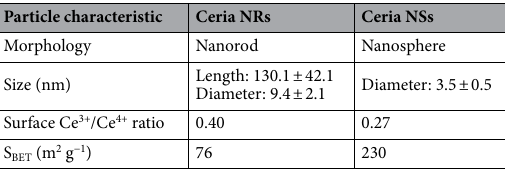
Table 1. Characterization of ceria nanoparticles. S BET Brunauer–Emmett–Teller (BET) surface area of ceria nanoparticles.